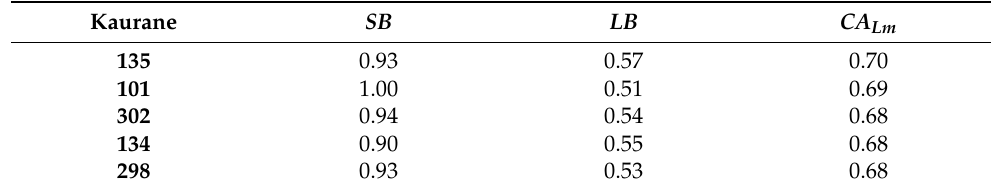
Table 2. Kauranes classified as active using an approach combining ligand-based and structure- based